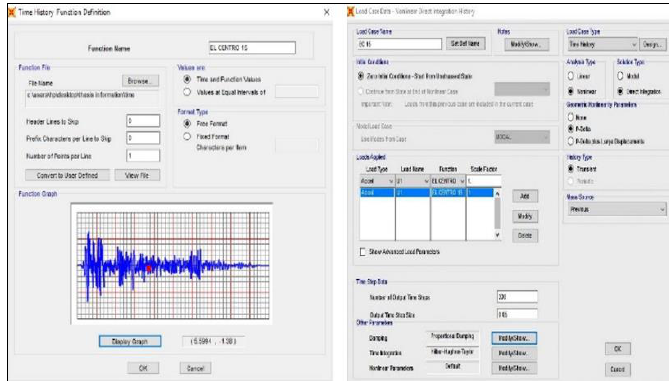
Figure 6: Time history function.